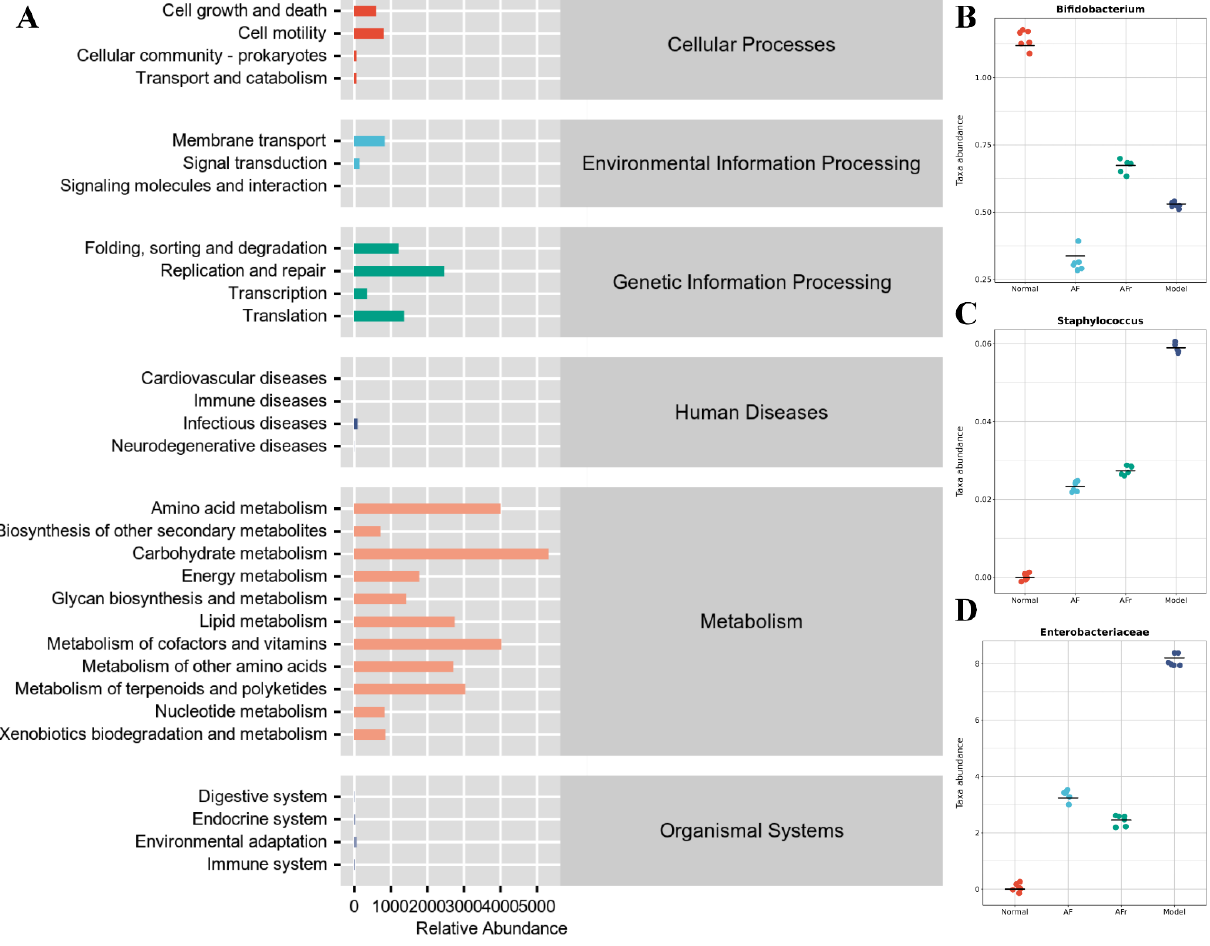
Figure 8. Metabolic pathways enrichment ( A ), and species composition difference analysis at the genus level between groups: ( B ) Bifidobacterium , ( C ) Staphylococcus , and ( D ) Enterobacteriaceae . Species composition difference analysis at the genus level between groups was con- ducted based on the above pathways. Enterobacteriaceae , Staphylococcus , and Bifidobacterium had high abundance in the model group than in the other groups (Figure 8). Staphylococcus was a common purulent coccus that predisposes to a variety of purulent infections [38]. Enterobacteriaceae was usually found in fresh produce and many Enterobacteriaceae were known pathogens, e.g., Salmonella and pathogenic E. coli [39]. The microorganisms of the Enterobacteriaceae family induced inflammation and infection in vivo [40]. The re-